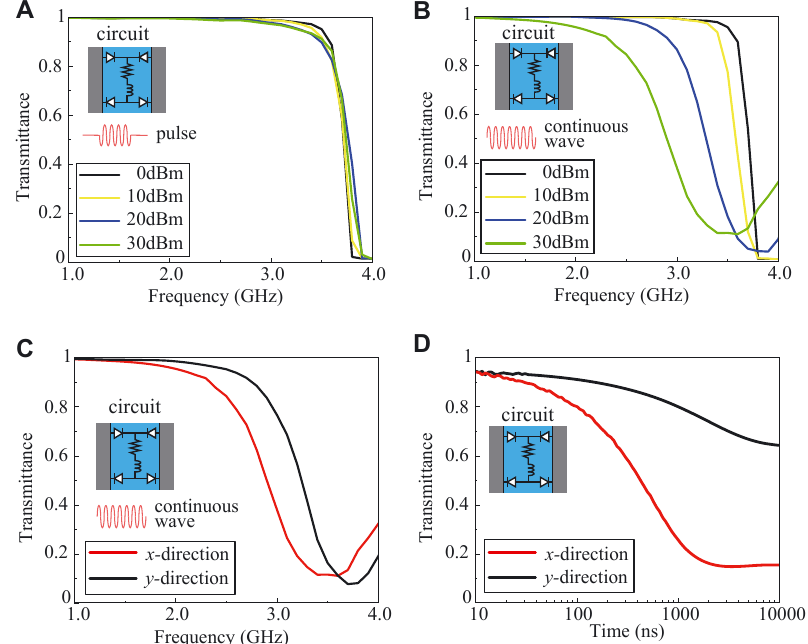
Figure 7: Surface wave propagation along the x direction (as in Figure 5A) at various power levels of (A) 50 ns pulse waves and (B) continuous waves. (C) Validation of anisotropic surface impedance. Surface waves are set to propagate along the x direction or the y direction (as in Figure 5B) for continuous waves at a power of 30 dBm. (D) Waveform selectivity of the surface wave propagation along the x and y directions at 3.0 GHz. The incident power is fixed at 30